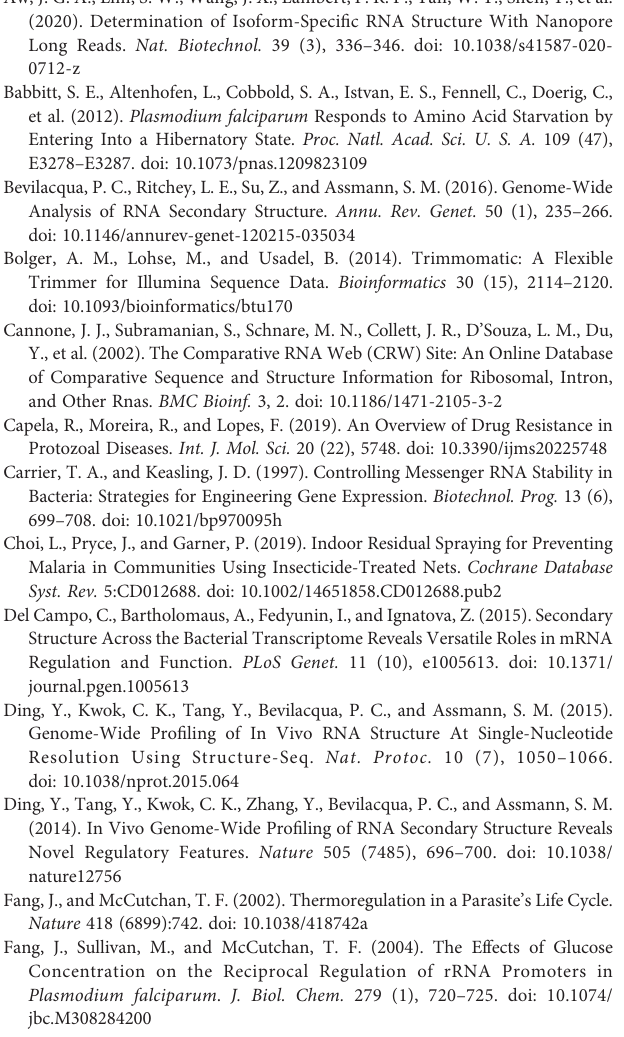
Supplementary Figure 2 | Determination of fragmentation time by primer extension electropherograms Determination of fragmentation time by primer extension electropherograms. Appropriate sizes of fragments are need for ef fi cient obtain modi fi cation sites via RT-PCRand sequencing.Short RNAs,~100nt, arethe most strategies that have been optimized to achieve single-hit kinetics of chemical modi fi cation. “ 1 min ” , “ 2min ” , “ 3 min ” and “ 4 min ” show the total RNA were